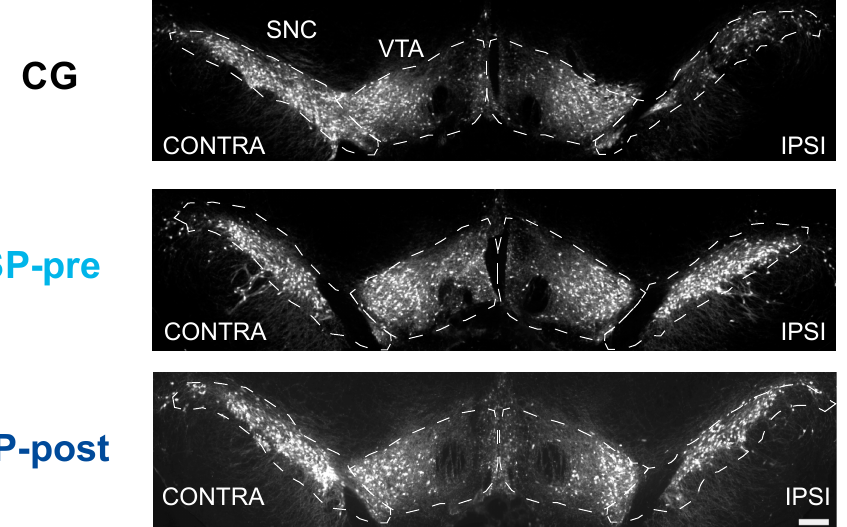
Figure 3. Dopaminergic neurodegeneration after stroke is attenuated by Substance P. ( A ) Intrain- dividual comparison of TH-positive neuron counts between contra- and ipsilesional hemisphere revealed ipsilesional neuron loss in control animals. ( B , C ) In SP-pre and SP-post animals, no ipsi- lesional dopaminergic degeneration was observed. ( D ) Between-group comparisons of ipsile- sional/contralesional TH-positive cell count ratios revealed significant differences between groups for the whole hemisphere and SNC. ( E ) Representative light-microscopy images (10 × magnification) indicate bilateral midbrain TH-immunoreactivity 15 days after stroke induction. Please note the obvious loss of TH-positive neurons within the ipsilesional SNC of a control rat. Scale bar: 100 µm. RRF: retrorubral field, SNC: substantia nigra pars compacta, VTA: ventral tegmental area. * p < 0.05, ** p < 0.01. Data are presented as mean ± SEM.